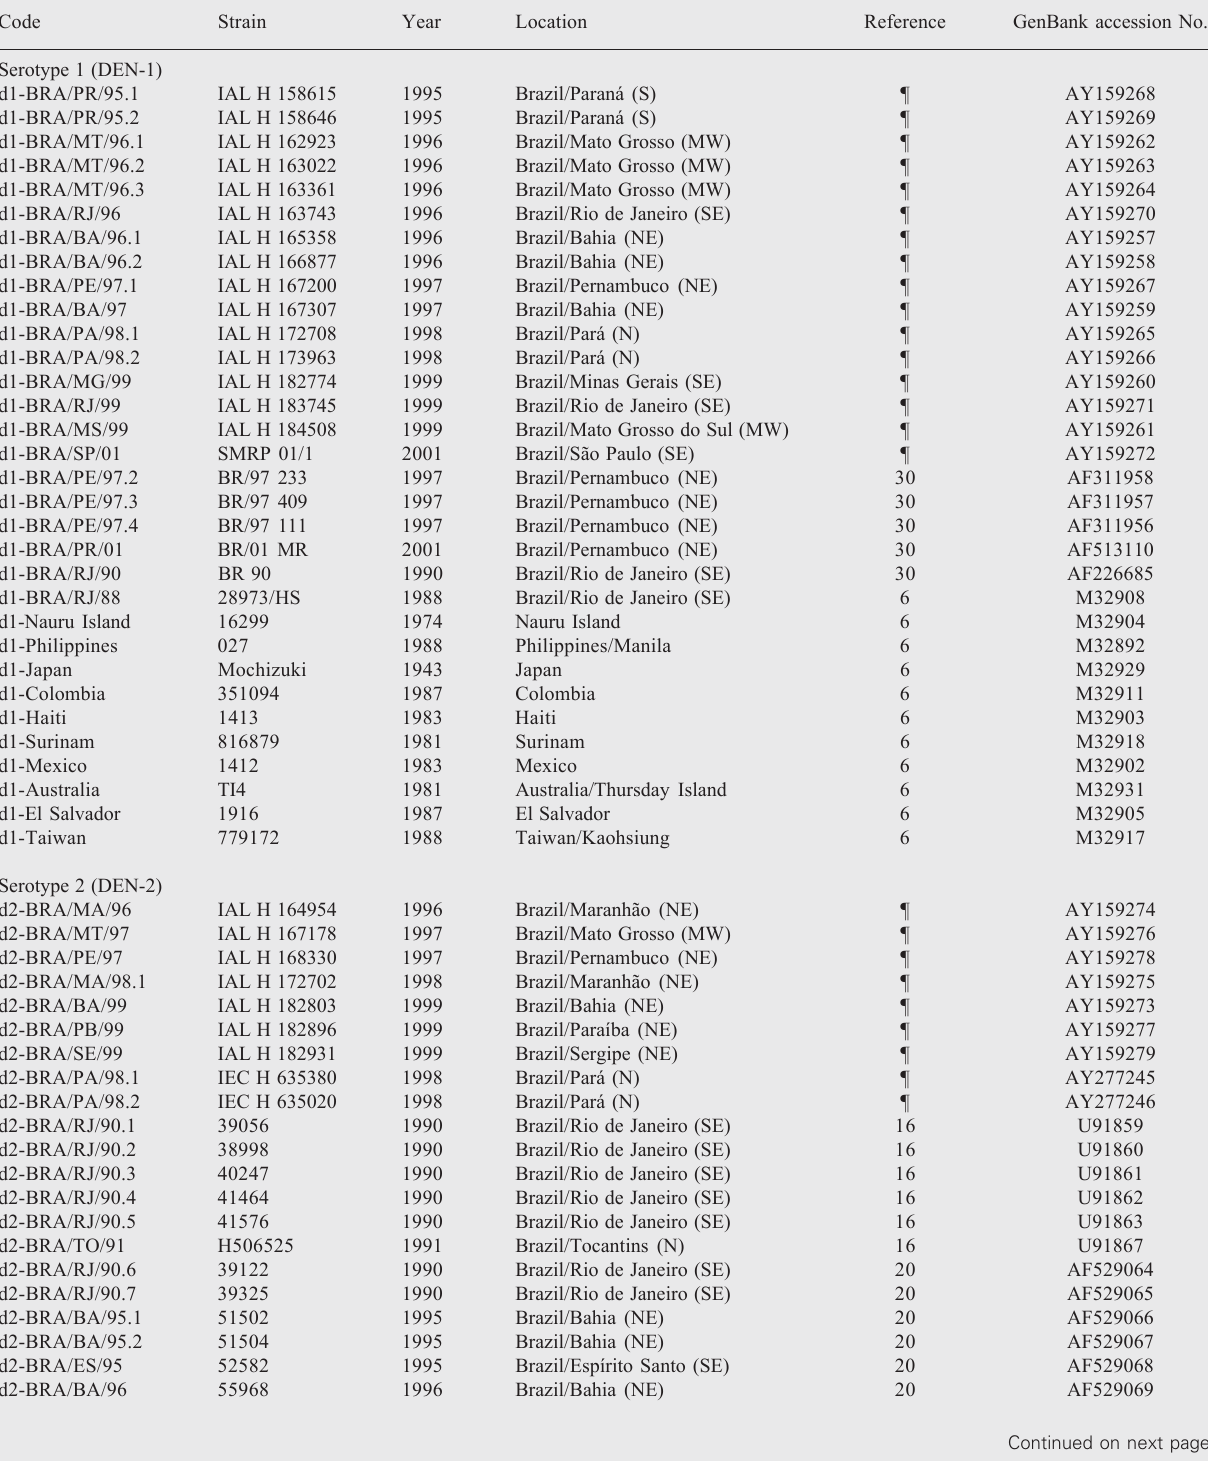
Table 1. Dengue virus strains compared by sequence analysis.